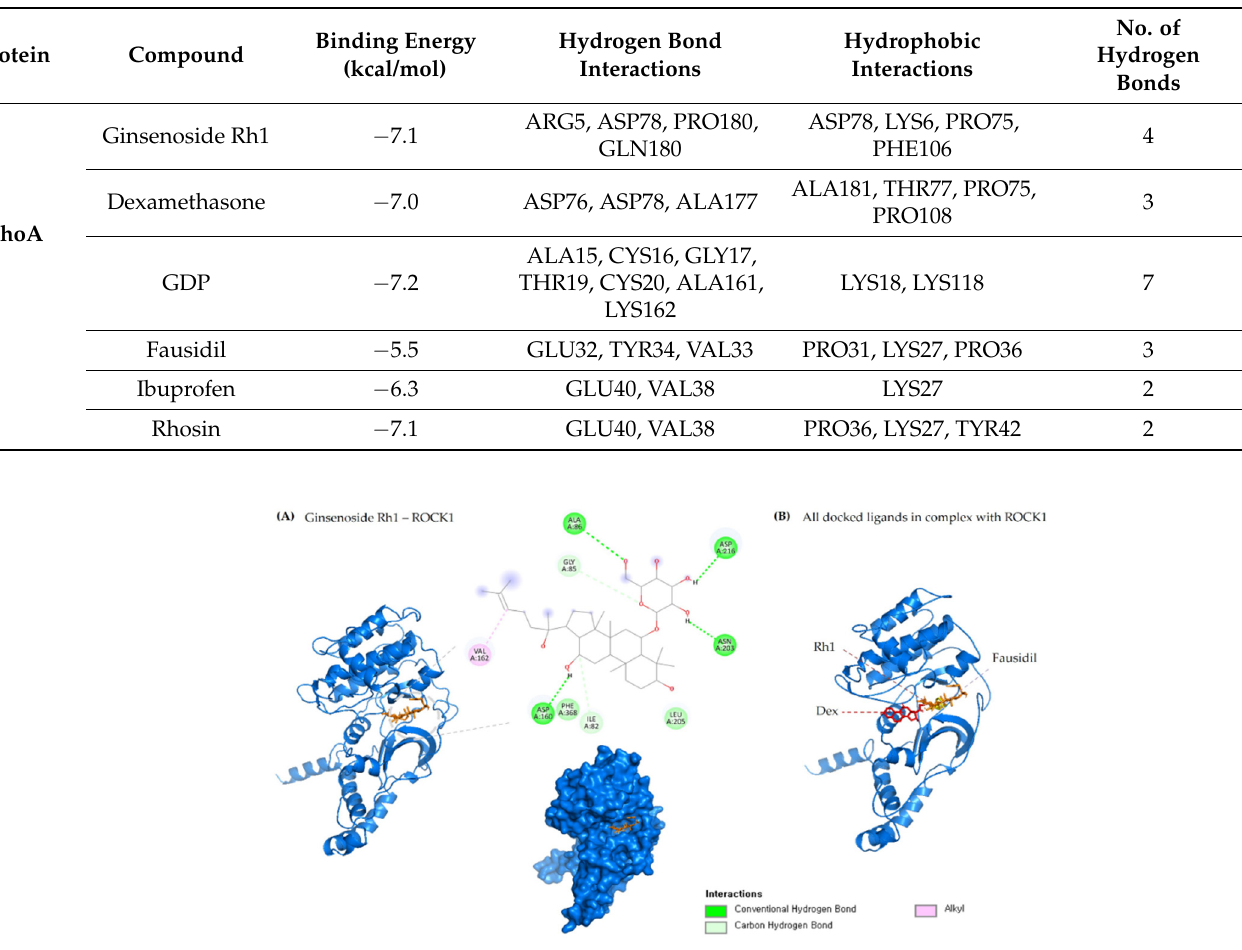
Table 4. Interaction of ginsenoside Rh1 and control drugs with amino acid residue of ROCK1 & RhoA.